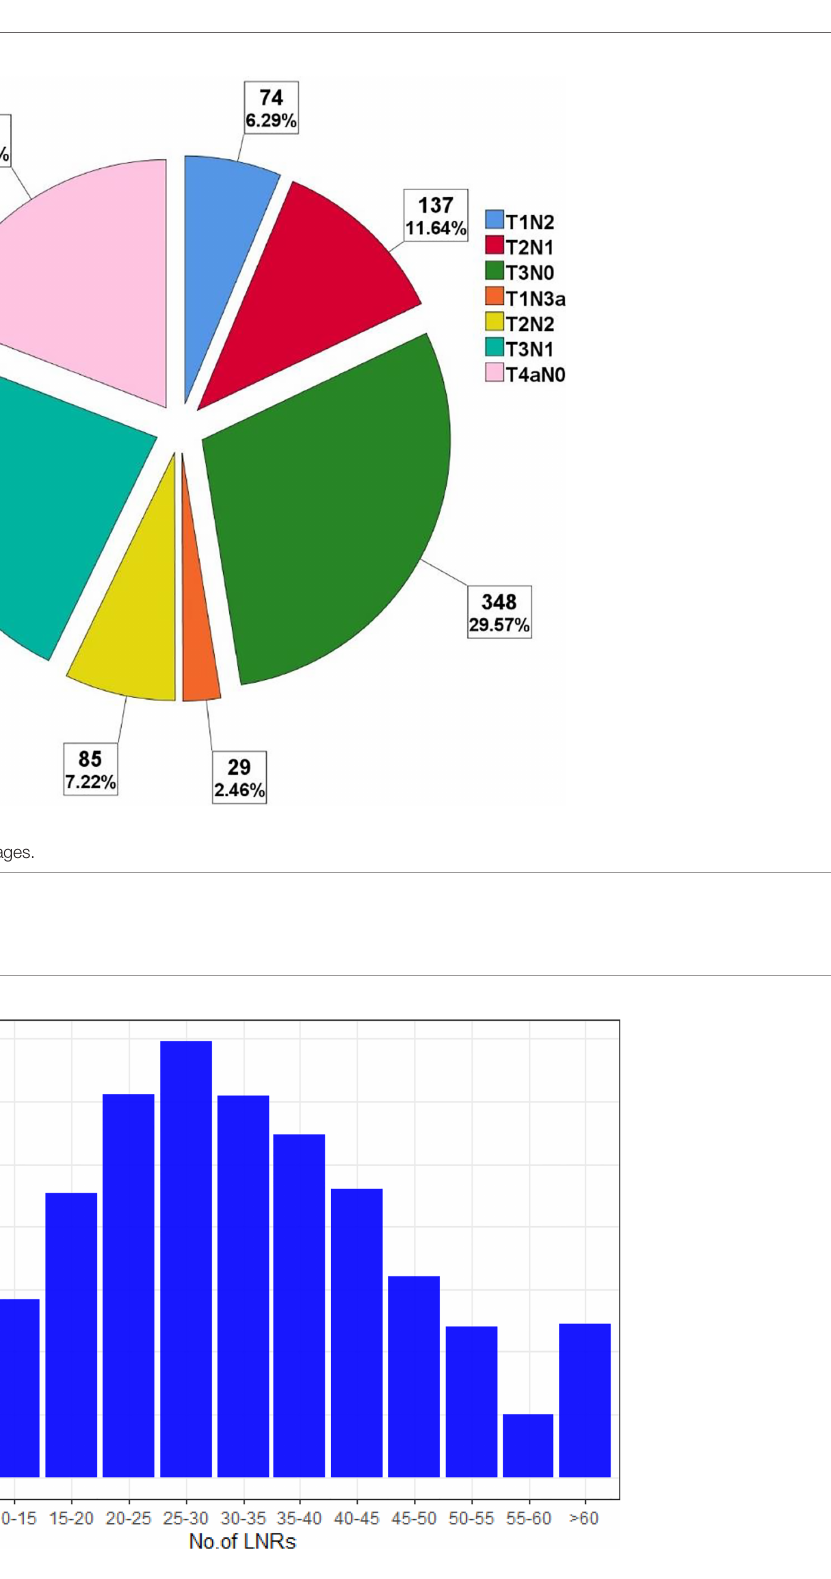
FIGURE 2 | The distribution of patients according to the number of